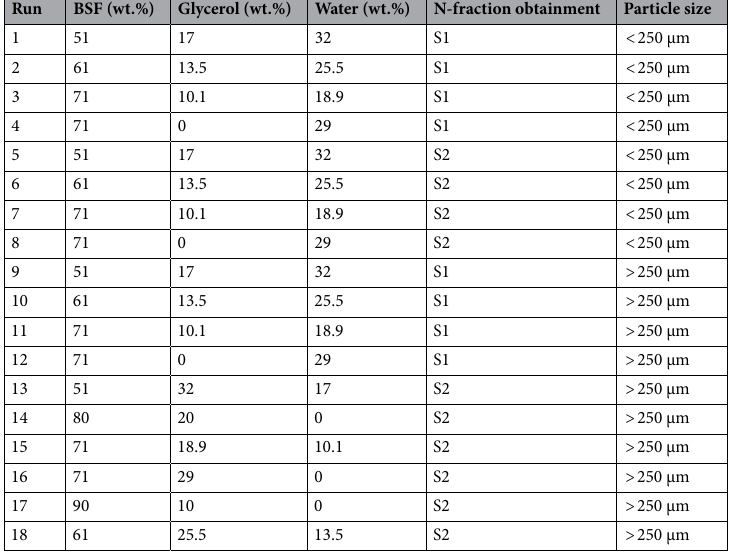
Table 2. Experimental plan obtained with Design Expert 13.